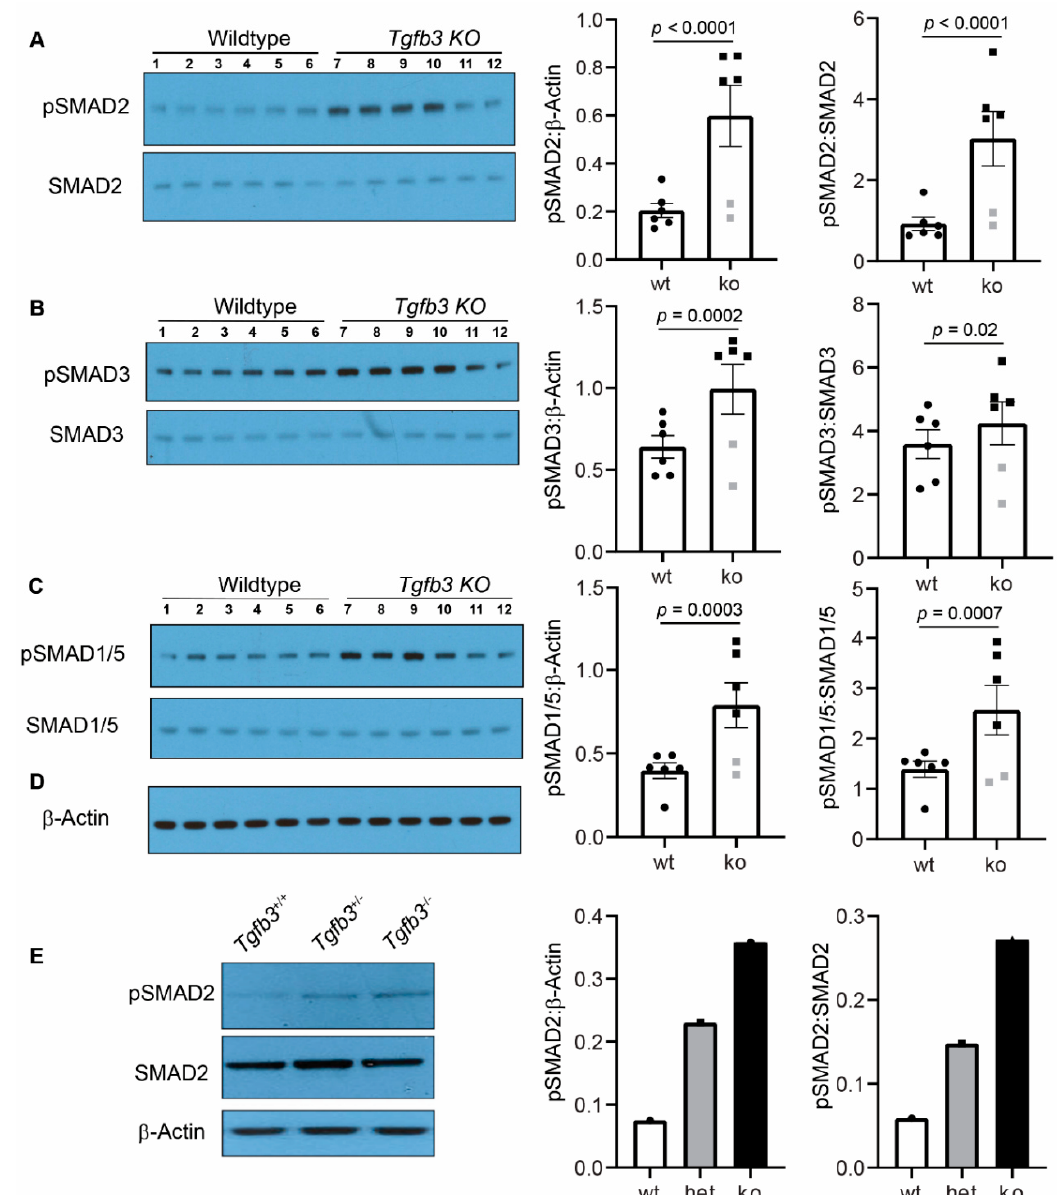
Figure 6. TGF β 3 is required for TGF β -SMAD cardiovascular pathway activation. ( A – C ), Western blot analysis of fetal hearts and the accompanied ascending aorta (E18.5) shows protein levels of the phosphorylated SMADs (pSMAD2, pSMAD3, pSMAD1/5) and total SMADs (SMAD2, SMAD3, SMAD1/5). ( D ) A common and independent β -actin blot ( C , bottom) was used for normalizing data from pSMAD2, pSMAD3, and pSMAD1/5 blots. There was no difference in the β -actin levels between any cardiovascular tissues taken from wildtype and Tgfb3–/– mice. Densitometric quantification of phosphorylated proteins after normalization to β -actin and total non-phosphorylated proteins is